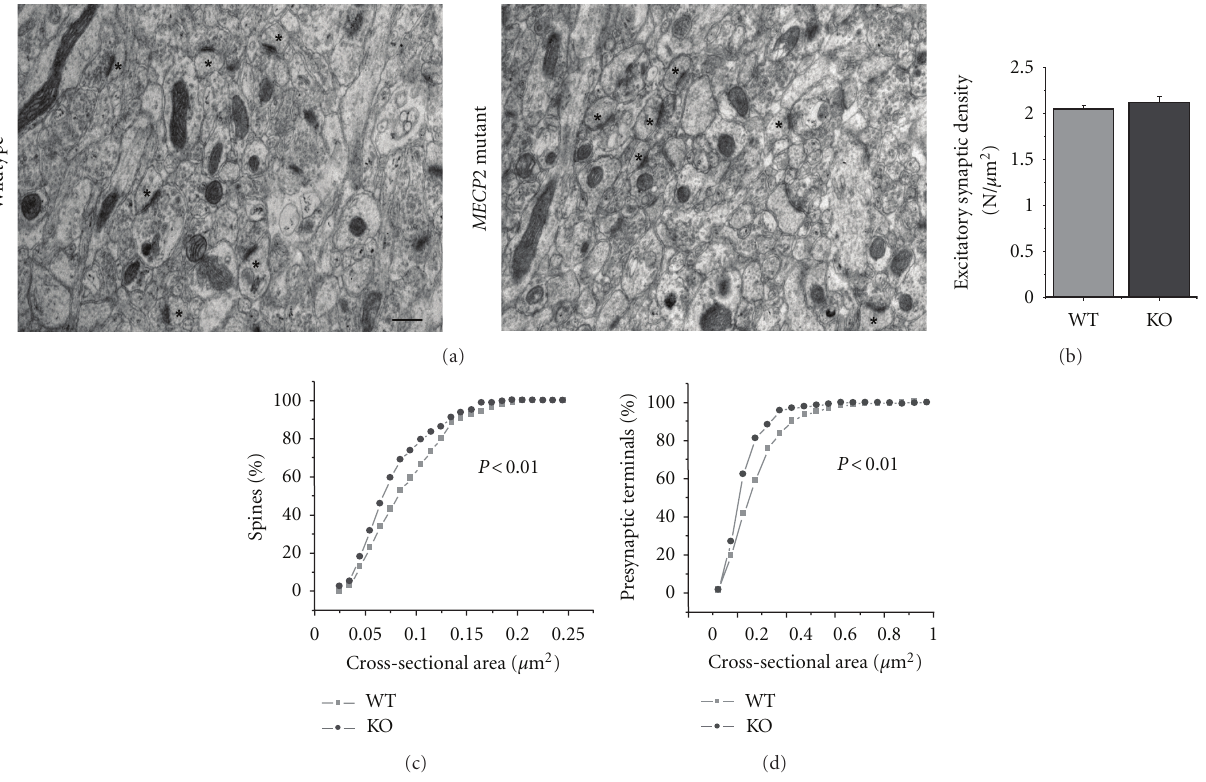
Figure 3: Quantitative electron microscopic analyses of CA3-CA1 excitatory synapses in the hippocampus of symptomatic Mecp 2 tm 1 . 1Jae mutant mice and age-matched wildtype littermates. (a) Electron micrographs of stratum radiatum in the CA1 area of the hippocampus from wildtype and symptomatic male Mecp 2 tm 1 . 1Jae mutant mice (P56). Representative excitatory synapses are indicated (asterisks). Scale bar: 400 nm. (b) Histograms show the number per unit of volume of asymmetric/excitatory CA3-CA1 synapses in CA1 stratum radiatum . The analysis using stereology (dissector method) revealed that MECP2 mutation does not a ff ect excitatory synapse number. (c) Cumulative percentage of the cross-sectional area of dendritic spines associated with asymmetric CA3-CA1 synapses. Area of the dendritic spine was determined when associated with a presynaptic terminal. (d) Cumulative percentage of the cross-sectional area of presynaptic terminals associated with asymmetric CA3-CA1 synapses. Area of the presynaptic terminals was determined when associated with a dendritic